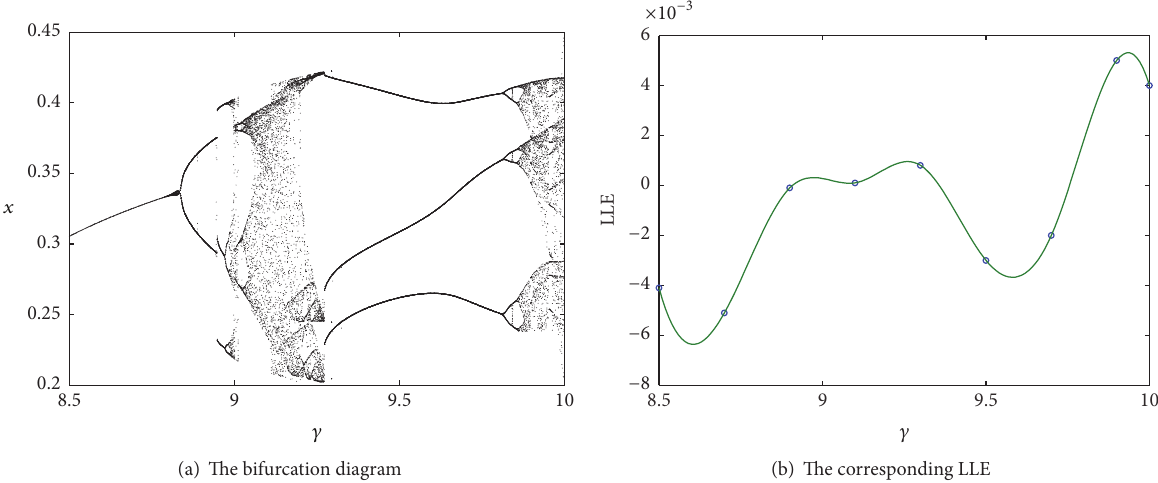
Figure 7: The bifurcation and the corresponding LLE diagrams of system (2) with the parameter 𝛾 ∈ [8.5, 10] .